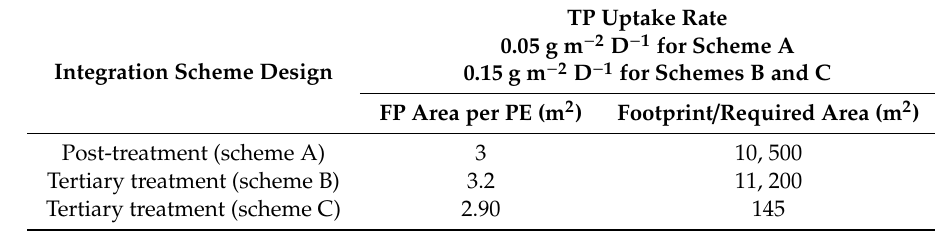
Table 4. Calculated design parameters of a biofilm system for P removal based on concrete slabs. PE = person equivalent. FP Area = footprint